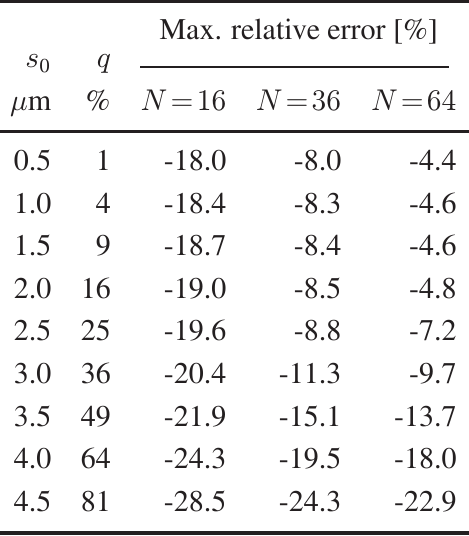
simulated with the PPR t = 0 . 5 µ m . . . 5 µ m. Comparison is made c